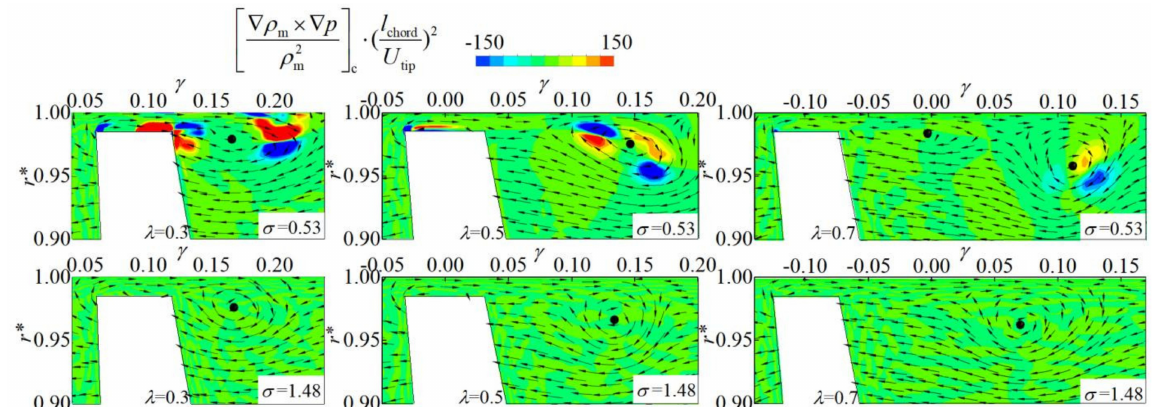
Figure 22. Comparison of the vortex baroclinic torque term distributions on the three planes for the cavitating case ( upper ) and non-cavitating case ( lower